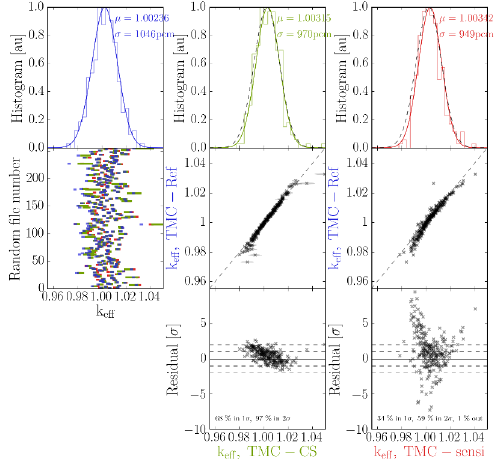
During the Serpent2 initialisation phase, an optional "autopert" key has been added in the material